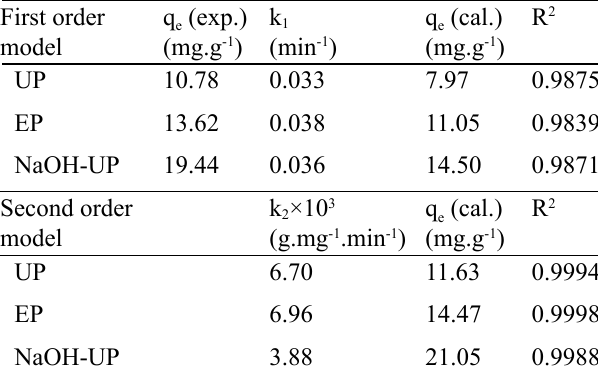
Table 3. Parameters of the first-order and second-order kinetics models for MG adsorption onto the studied adsorbents.